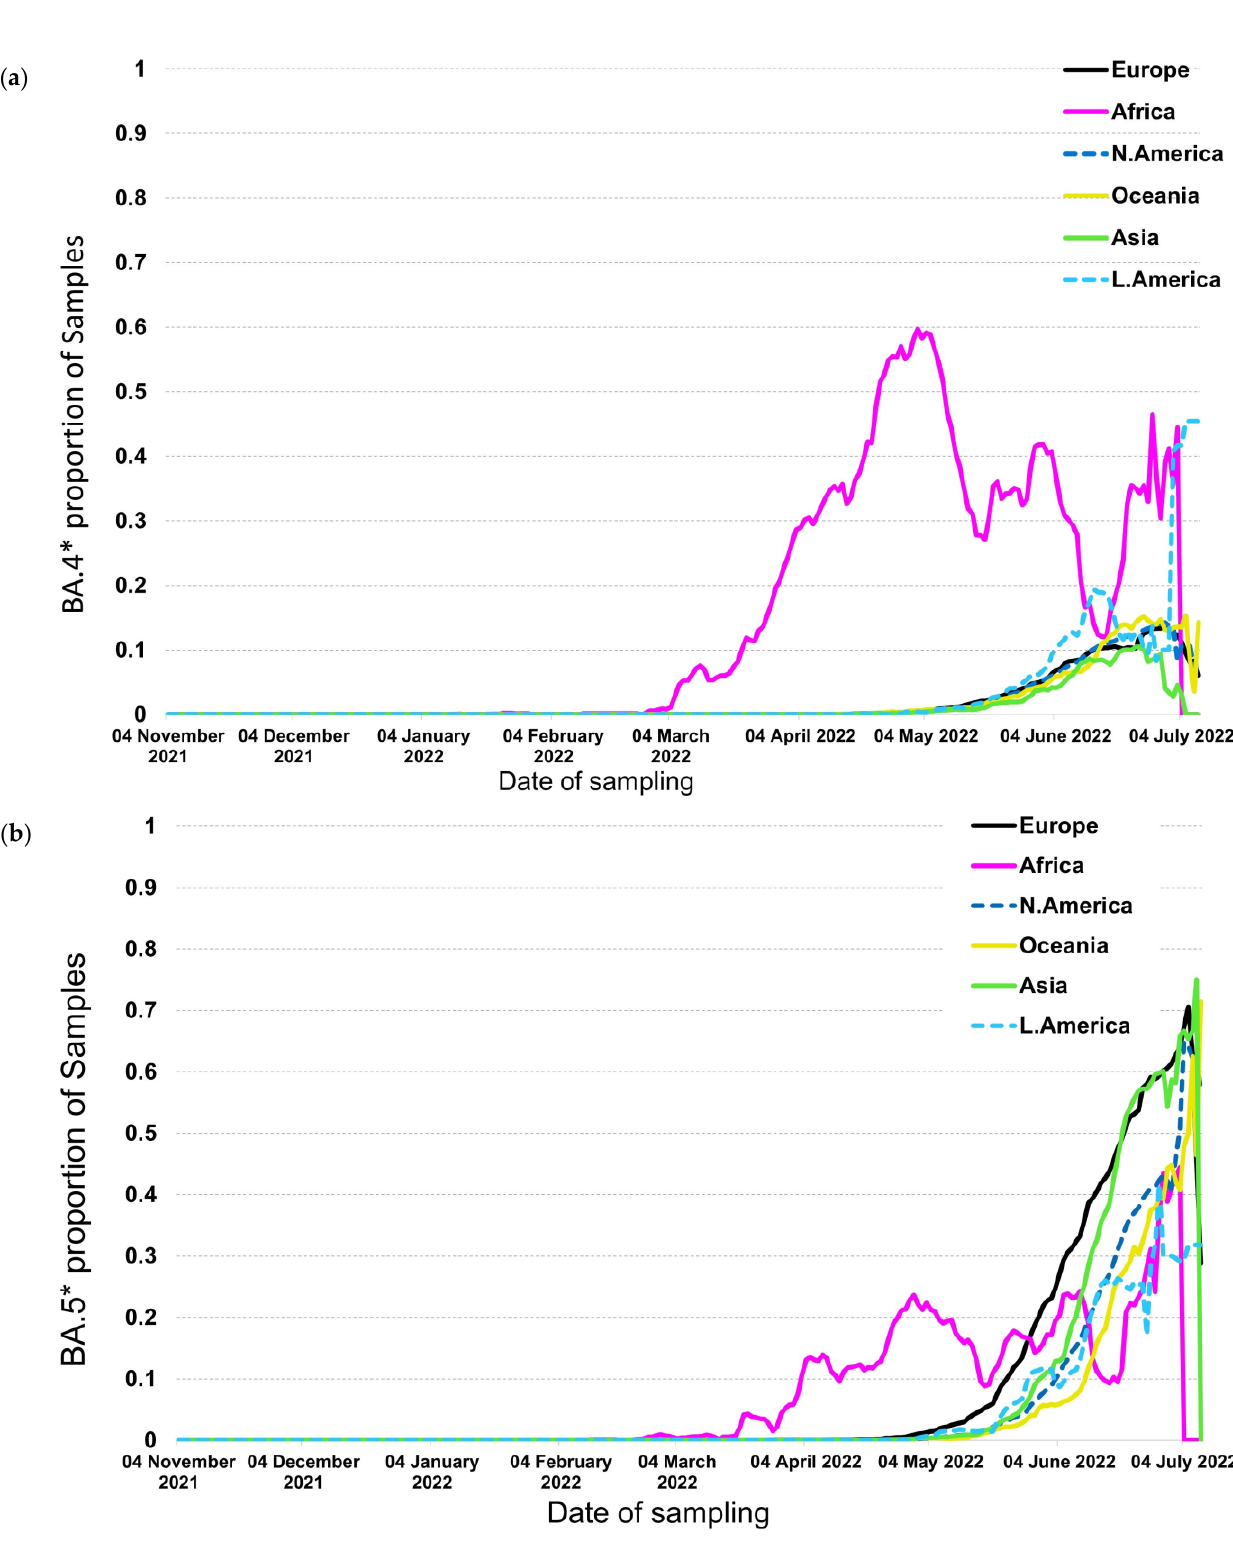
Figure 4. Proportion of samples over time by continent for ( a ) BA.4* and ( b ) BA.5*.